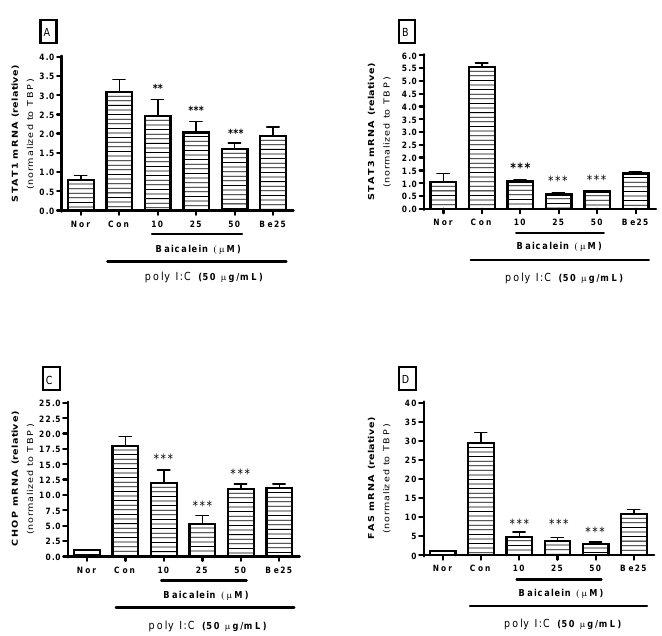
Figure 4. Effect of baicalein on mRNA expressions of STAT1 ( A ), STAT3 ( B ), CHOP ( C ), and Fas ( D ) in RAW 264.7 cells induced by poly I:C. After 18 h of treatment, mRNA expressions of STAT1 , STAT3 , CHOP , and Fas were measured by real-time reverse-transcription polymerase chain reaction assay. STAT1 , STAT3 , CHOP , and Fas mRNA levels were normalized to TBP mRNA. Normal group (Nor) was treated with media only. Control group (Con) was treated with poly I:C (50 μg/mL) alone. Be25: berberine (25 μM). Values are mean ± standard deviation of three independent experiments. ** p < 0.01 vs. Con; *** p < 0.001.